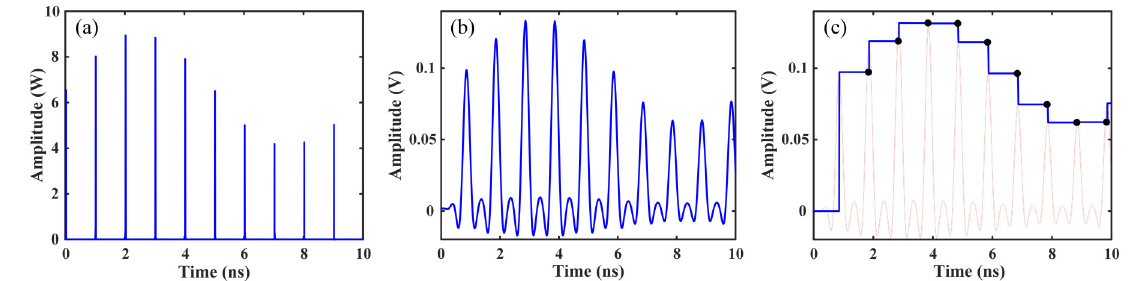
Figure 6. Simulation results for photonic sampling. ( a ) Waveform of the sampled optical pulse train. ( b ) Waveform from the PD. ( c ) Waveform from the T/H circuit.